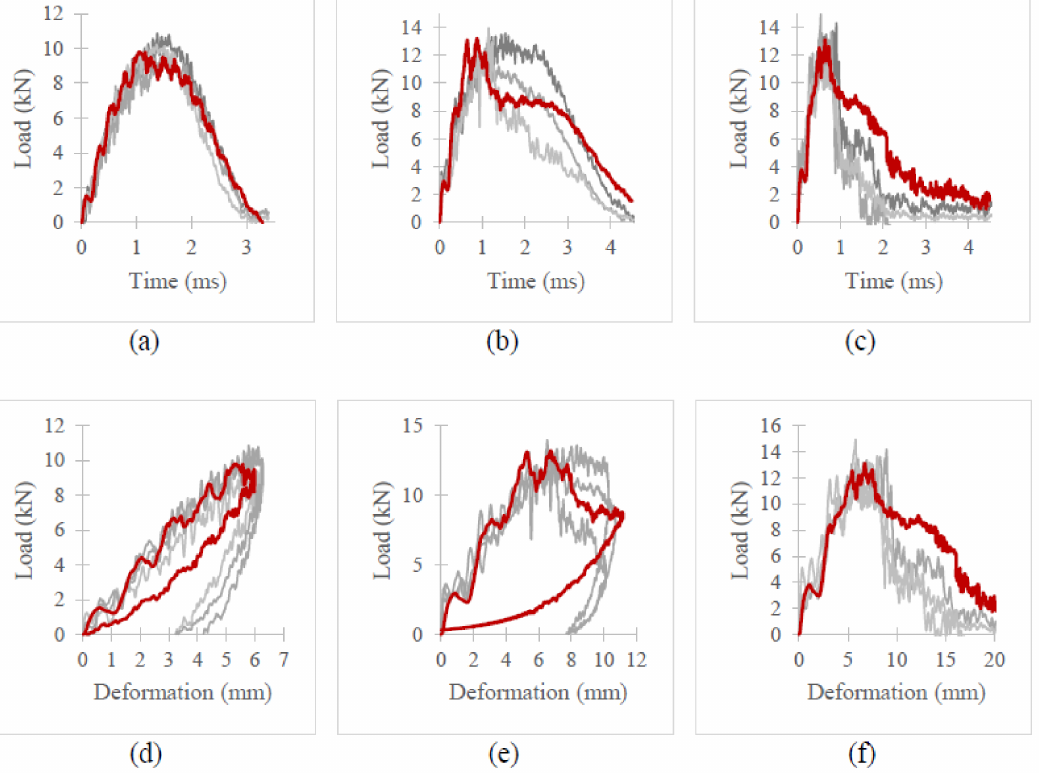
Figure 14. Force–time histories ( a – c ) and force–displacement curves ( d – f ) for T700/PA6.6 at 40, 100 and 160 J. At 100 J, the correlation between the FE and experimental results is still reasonably similar since the FE results lie within the variation observed in the experiments (indicated by the three lines in different shades of grey). The load–time histories and load–displacement curves for both material systems only started to deviate upon damage propagation. This disparity seen in the T700/PA6.6 was due to the shear-plugging phenomenon observed during the experiment, which was clearly not accurately captured in the FE and could not be accounted for using continuum shell elements. In relation to the T700/PPS, the discrepancy was instigated by the severe delamination seen in the experiment, which also could not be thoroughly accounted for by the FE